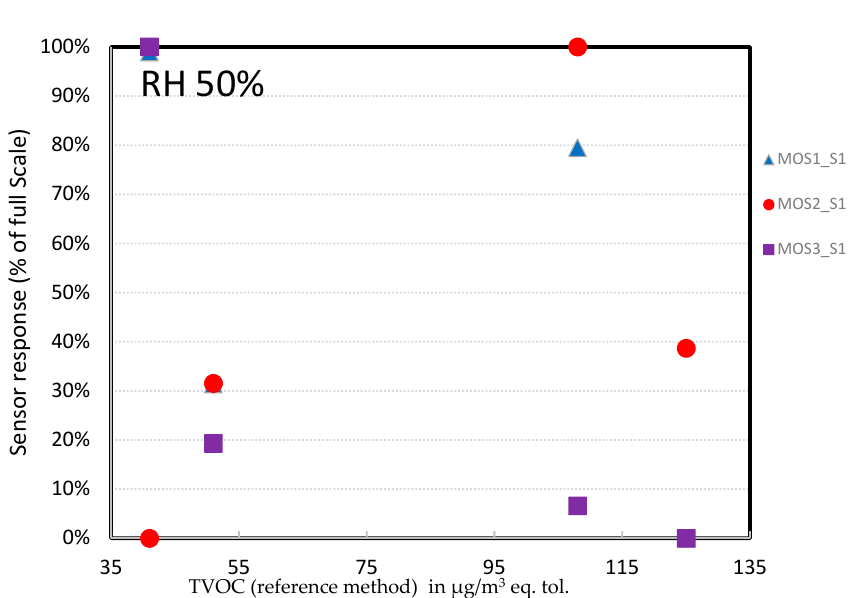
Figure 17. Linearity of MOS sensors (Supplier 2).